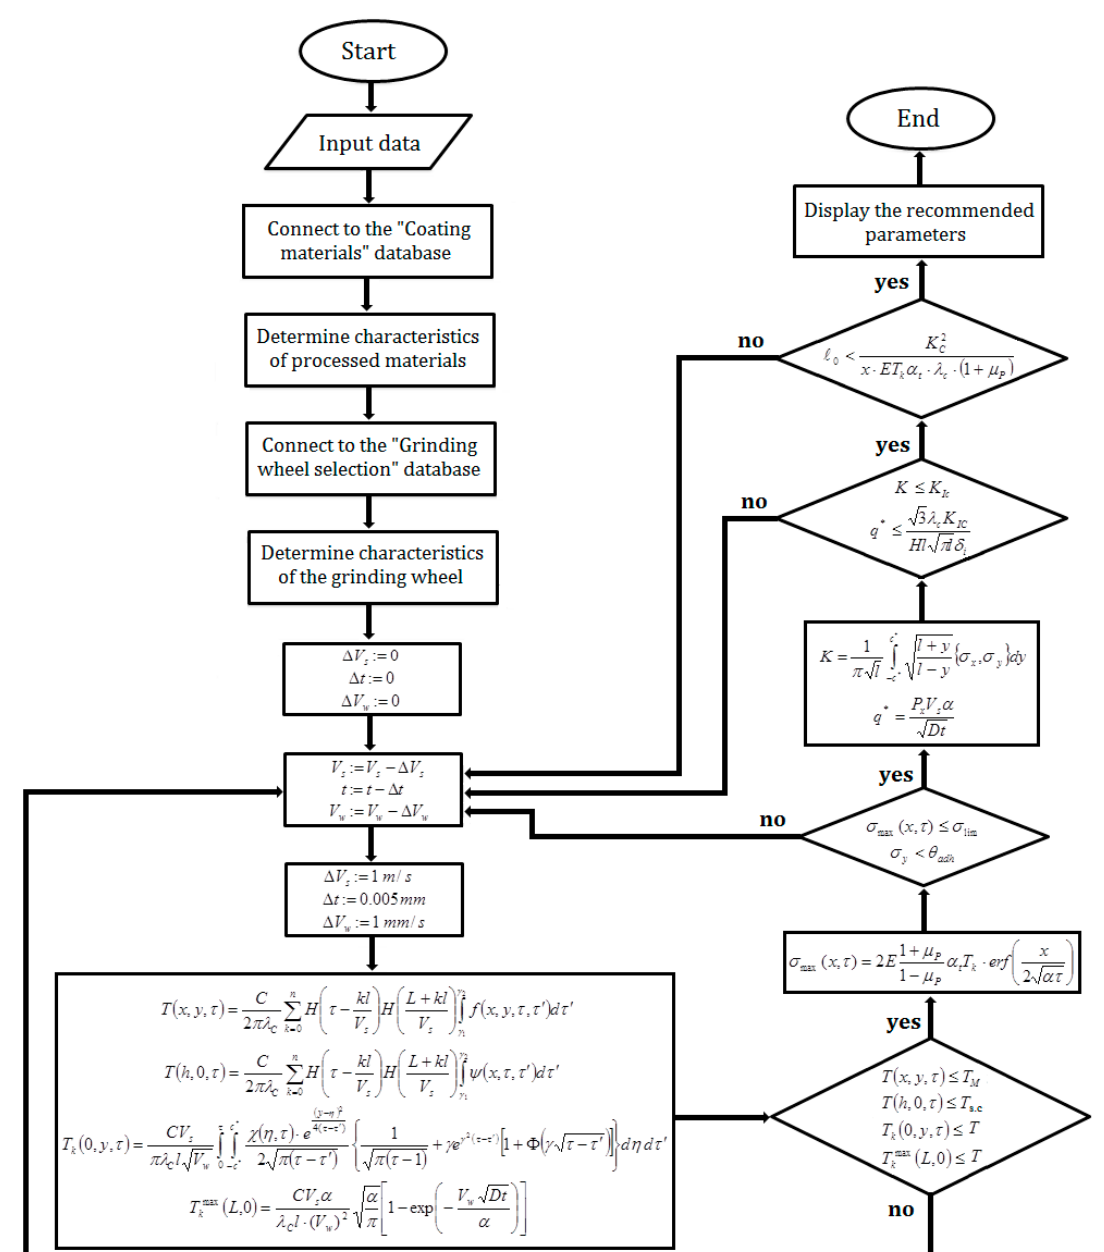
Figure 2. Condition monitoring algorithm for grinding plasma coatings.